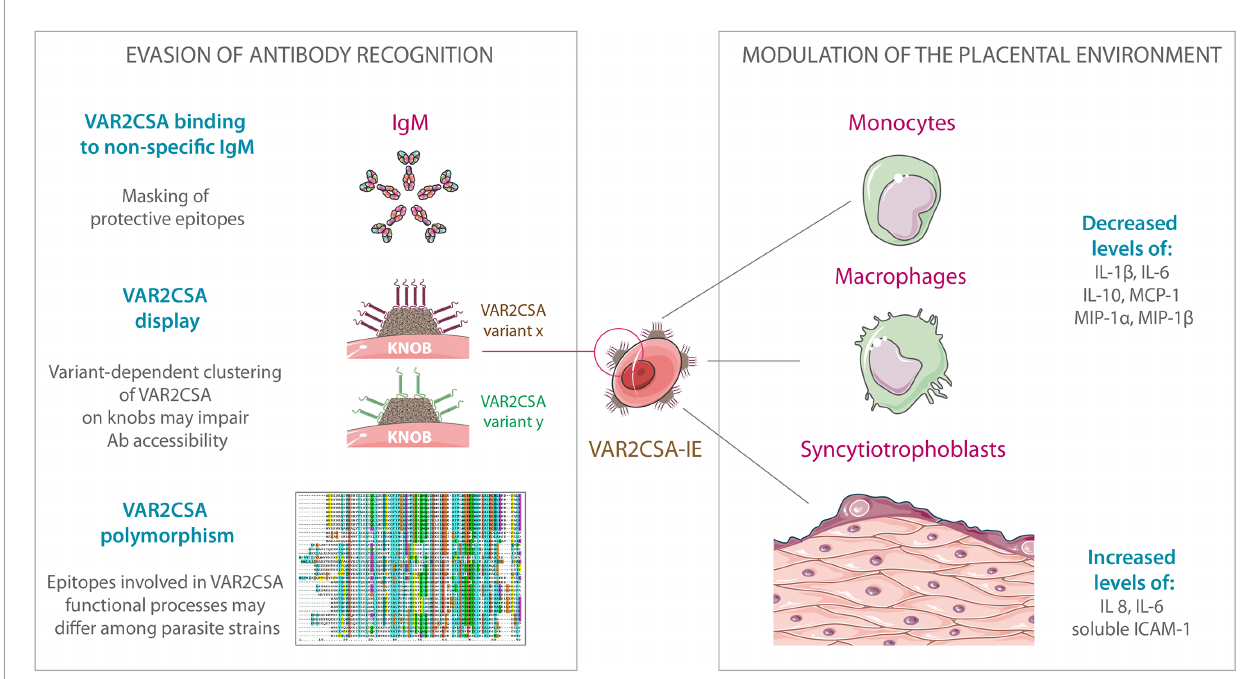
FIGURE 2 | Evasion of antibody recognition and modulation of the placental environment by VAR2CSA-expressing infected erythrocytes. IgM binding to VAR2CSA could mask protein epitopes recognized by anti-VAR2CSA IgGs and consequently alter opsonic phagocytosis of IEs. PfEMP1 clustering on knob structures may act as an immune evasion mechanism, impairing antibody accessibility to key residues involved in CSA-binding. Due to extensive polymorphism, epitopes involved in each VAR2CSA functional process may differ among parasite strains. Furthermore, multiplicity of var2csa genes within the parasite genome may also confer a greater capacity for antigenic variation and evasion of variant-speci fi c immune responses. The presence of VAR2CSA on the IEs surface could lead to decreased production of IL-1 b , IL-6, IL-10, MCP-1, MIP-1 a , and MIP-1 b by monocytes and macrophages. VAR2CSA-dependent binding of IEs to syncytiotrophoblasts is able to activate MAPK pathways and lead to increased secretion of IL-8, IL-6, and soluble ICAM-1. The art pieces used in this fi gure were modi fi ed from Servier Medical Art by Servier, licensed under a Creative Commons Attribution 3.0 Unported License (https://smart.servier.com/). The illustration of the protein sequence alignment